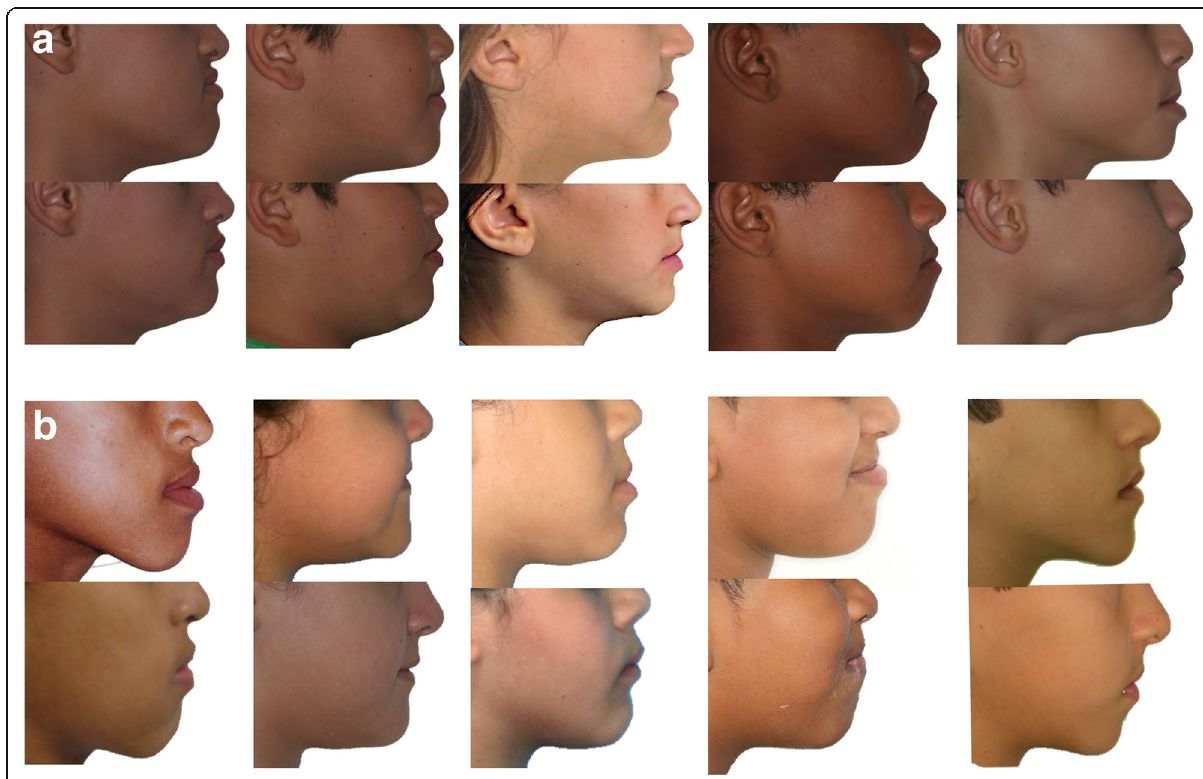
Fig. 3 Aspect of the facial profile before and after treatment, of five patients of group MI ( a ) and five patients of group FM ( b